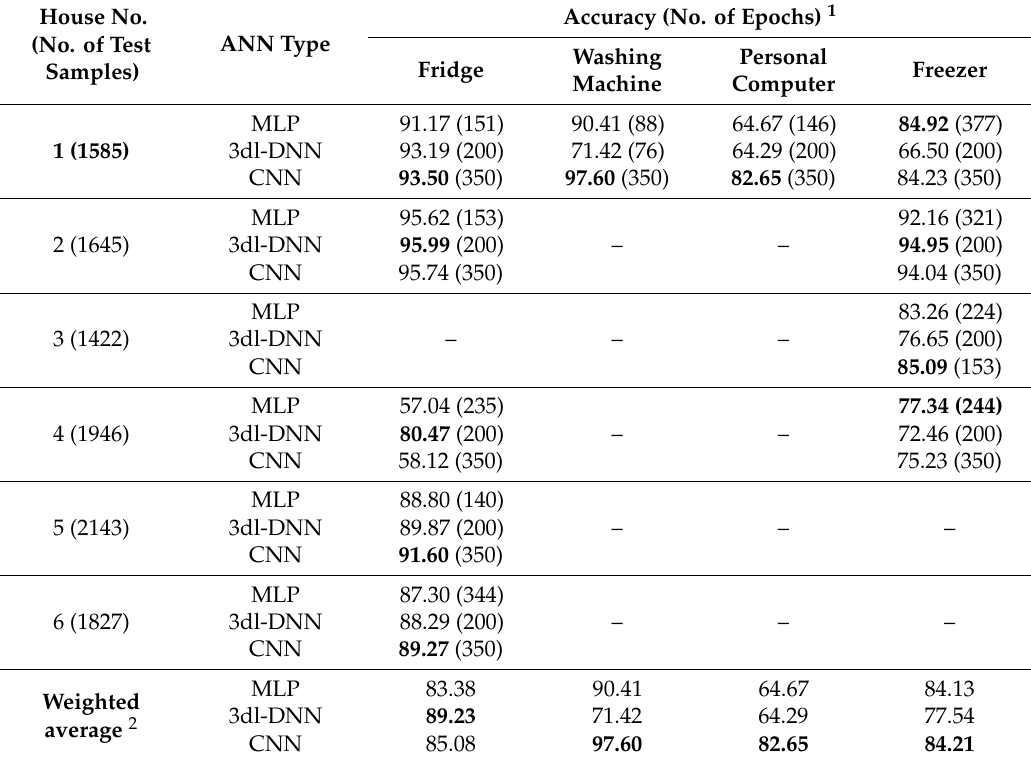
Table 6. Accuracy of disaggregation for three types of artificial neural networks (ANNs): multilayer